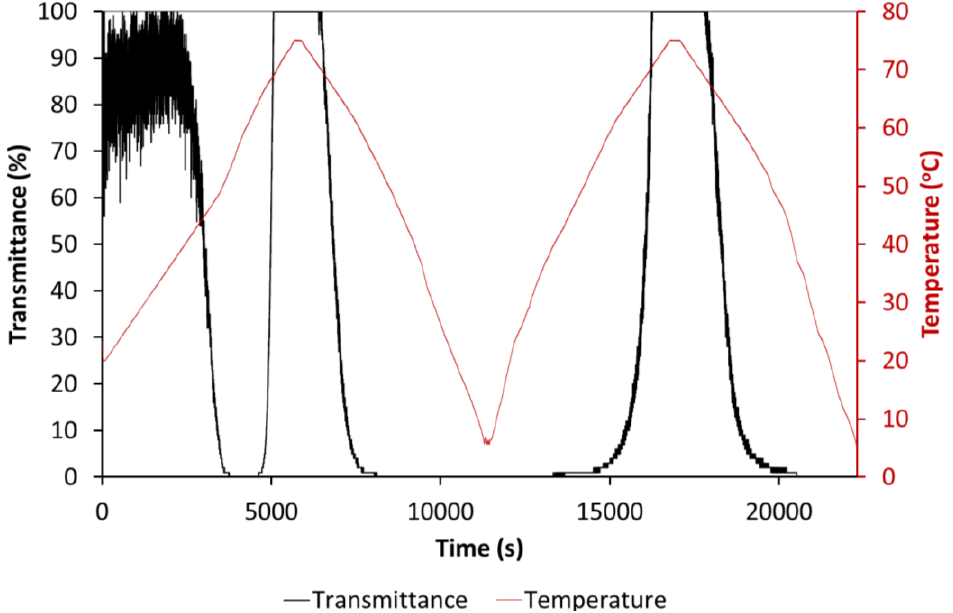
Figure 14. Turbidity data from cooling crystallisation of 5FC with 4CL35DNBA (1:2) in ethanol and water (7:3 by volume). The temperature regimes used are shown as the red trace.